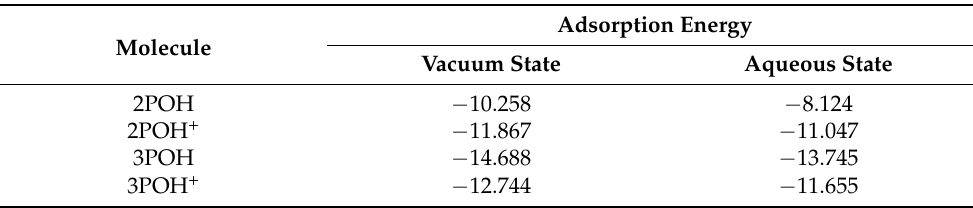
Table 2. Adsorption energies of neutral and protonated pyridine oximes adsorbed on Fe(110) surface obtained by MD simulation (in eV).